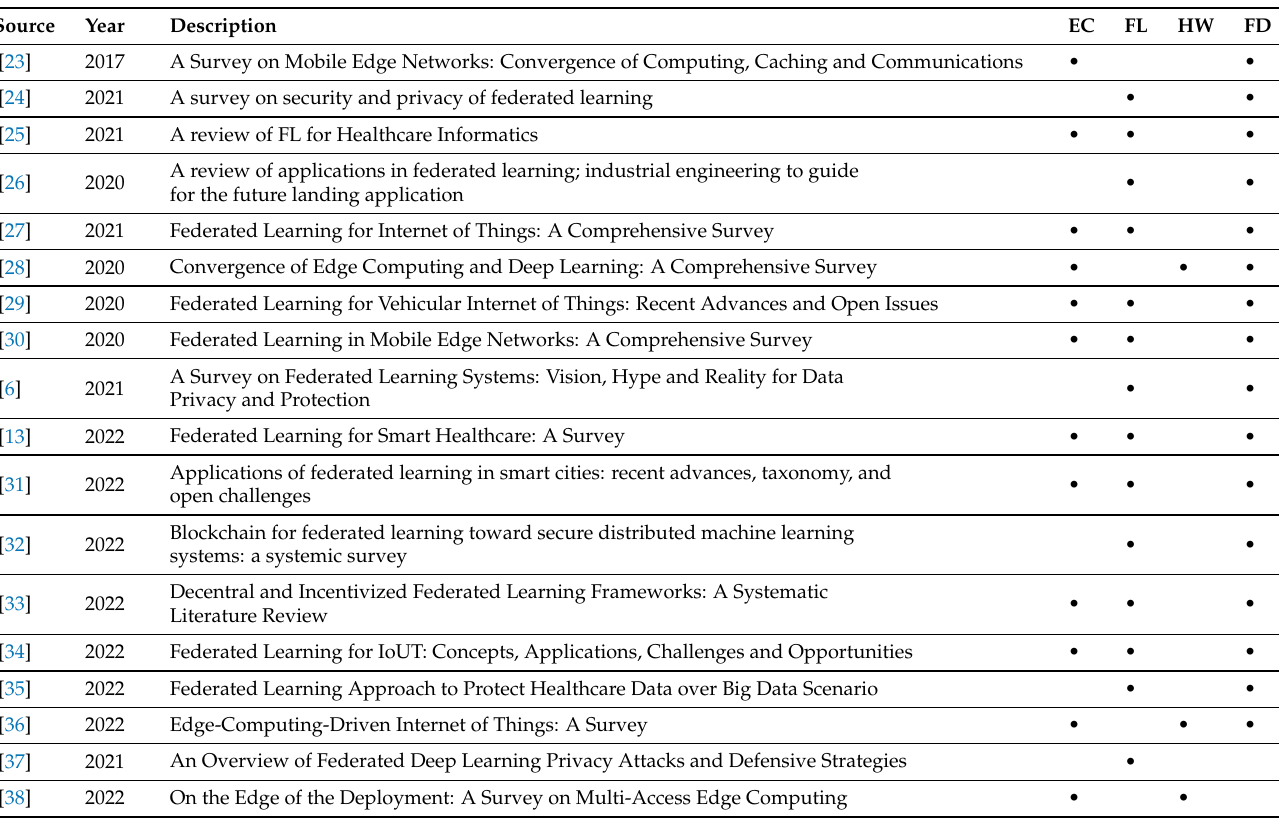
Table 1. Comparison of